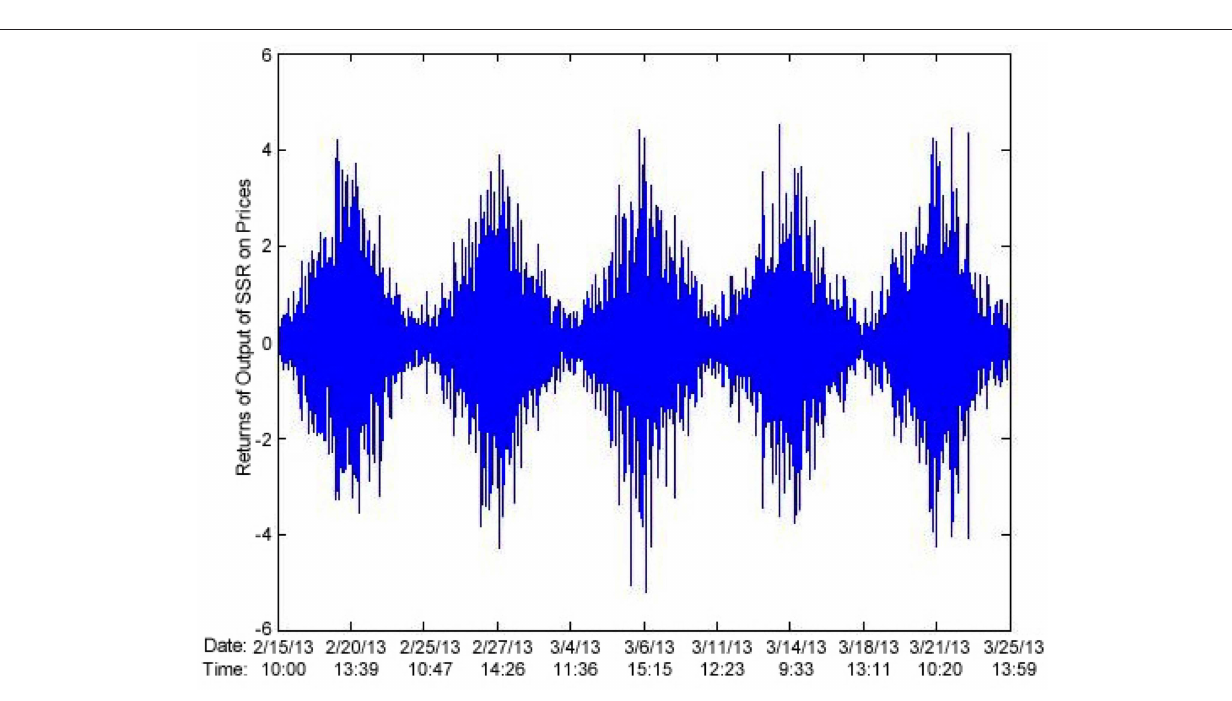
FIGURE 23 | Plot of log returns of output of SSR applied to the noise-corrupted signal in Figure